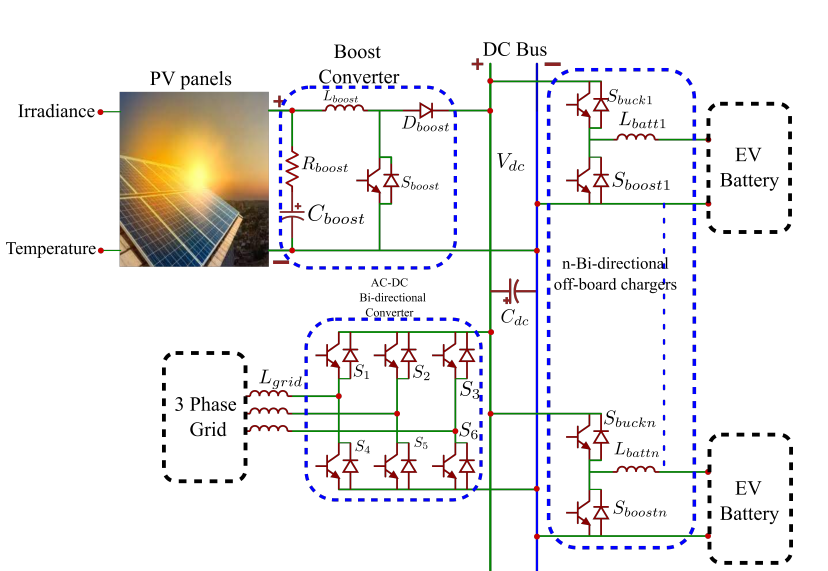
Figure 2. Illustration of microgrid that involves the vehicle simultaneous charging and